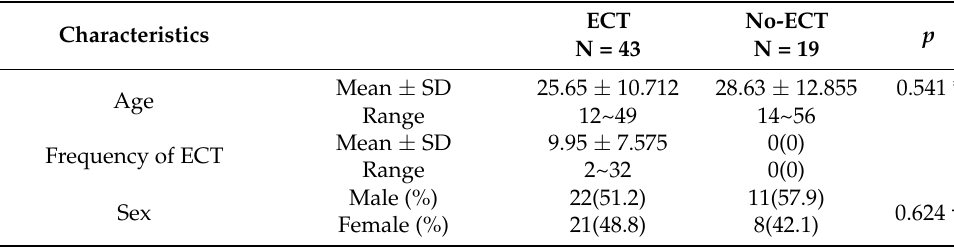
Table 1. Patients